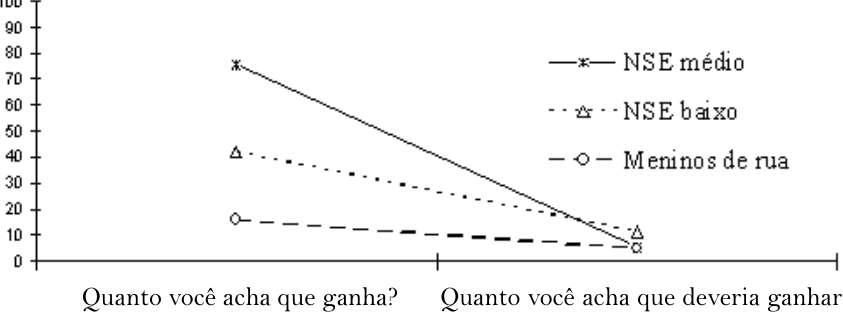
Figura 3 . Interação Grupo x Questão Acha/Deveria.VD: Razão da remuneração entre